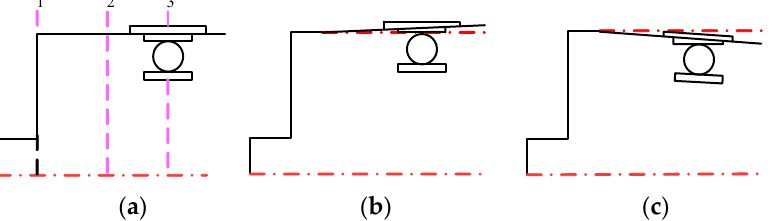
Figure 7. Diagram of the deformation of the flexible wheel structure before and after assembly. ( a ) Structure before assembly. ( b ) Long axis area structure after assembly. ( c ) Structure of short shaft area after assembly.